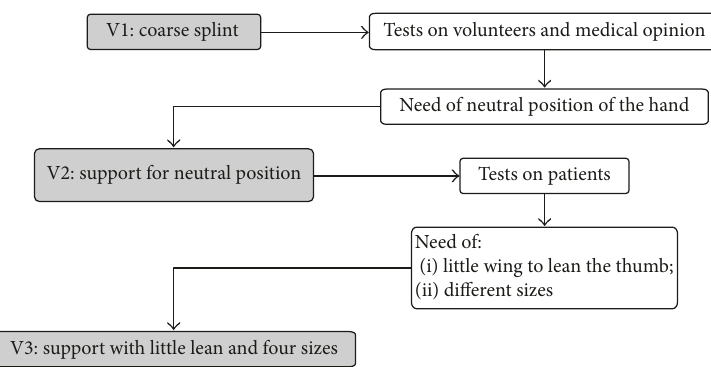
Figure 4: Operational work fl ow for the support design and